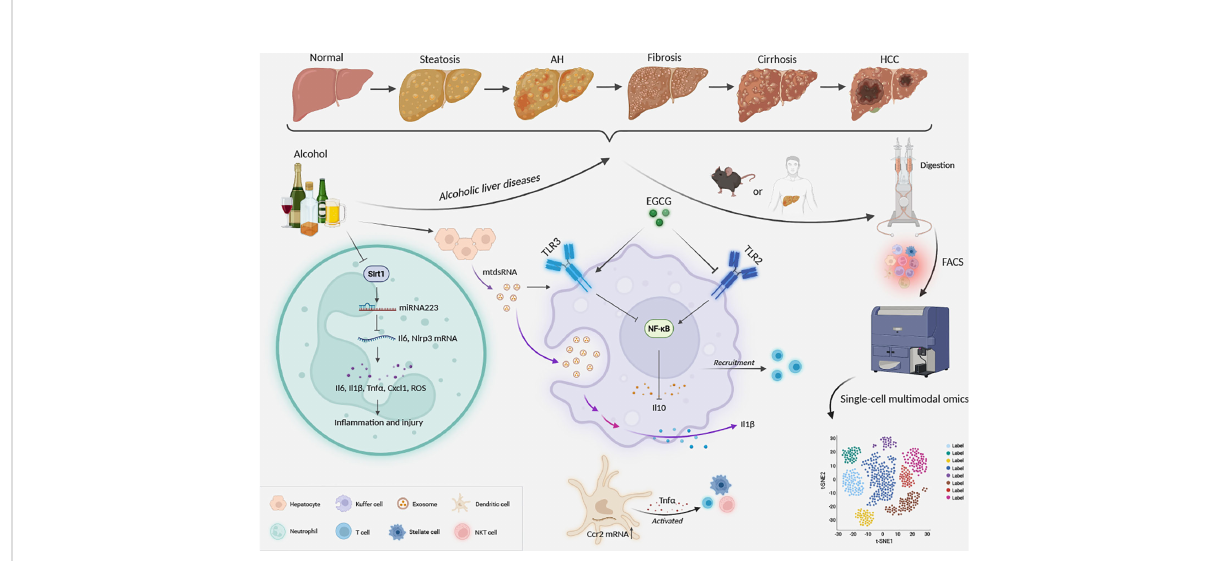
FIGURE 2 Mechanism and prospect of myeloid cells in alcoholic liver